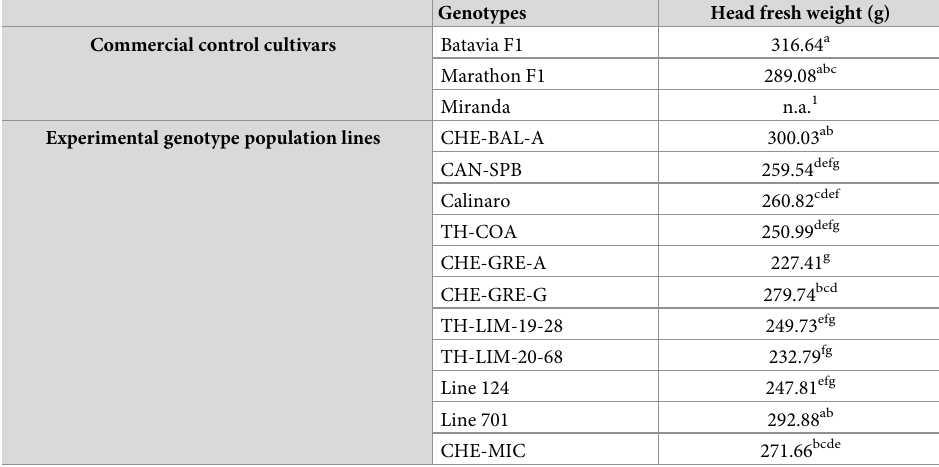
Table 3. Comparison of the mean values of head fresh weight (g) of different broccoli samples across growing sea- sons (fall 2015 and spring